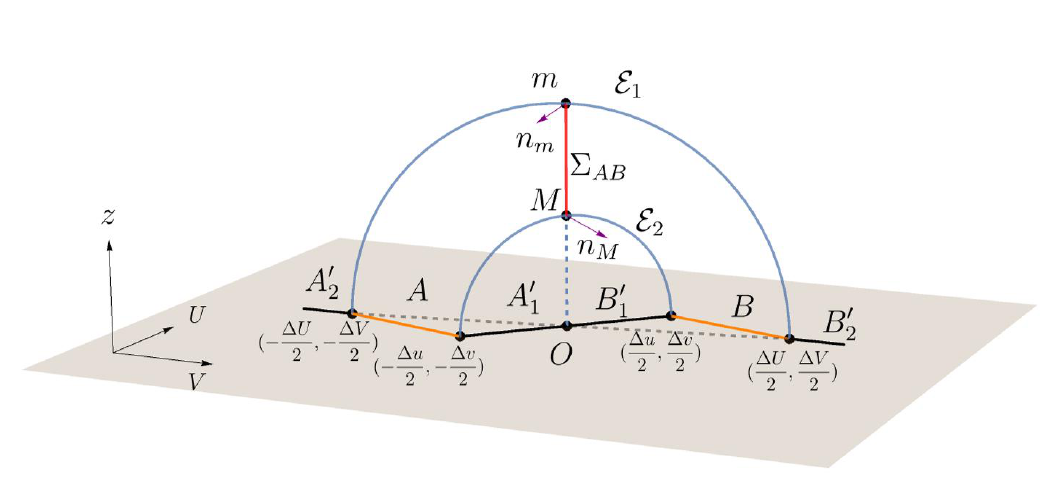
Figure 7: Illustration of EWCS for the two non-adjacent symmetric